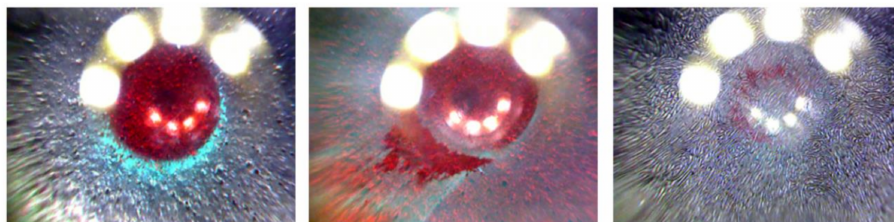
Figure 3. Sample images of pre-processed dataset, where the red color channel is replaced with the first frame of the corresponding video. ( Left ) Ideal case where only the contact area is highlighted. ( Middle ) Wear particles are also marked. ( Right ) Certain coatings diminish the e ff ects of pre-processing.